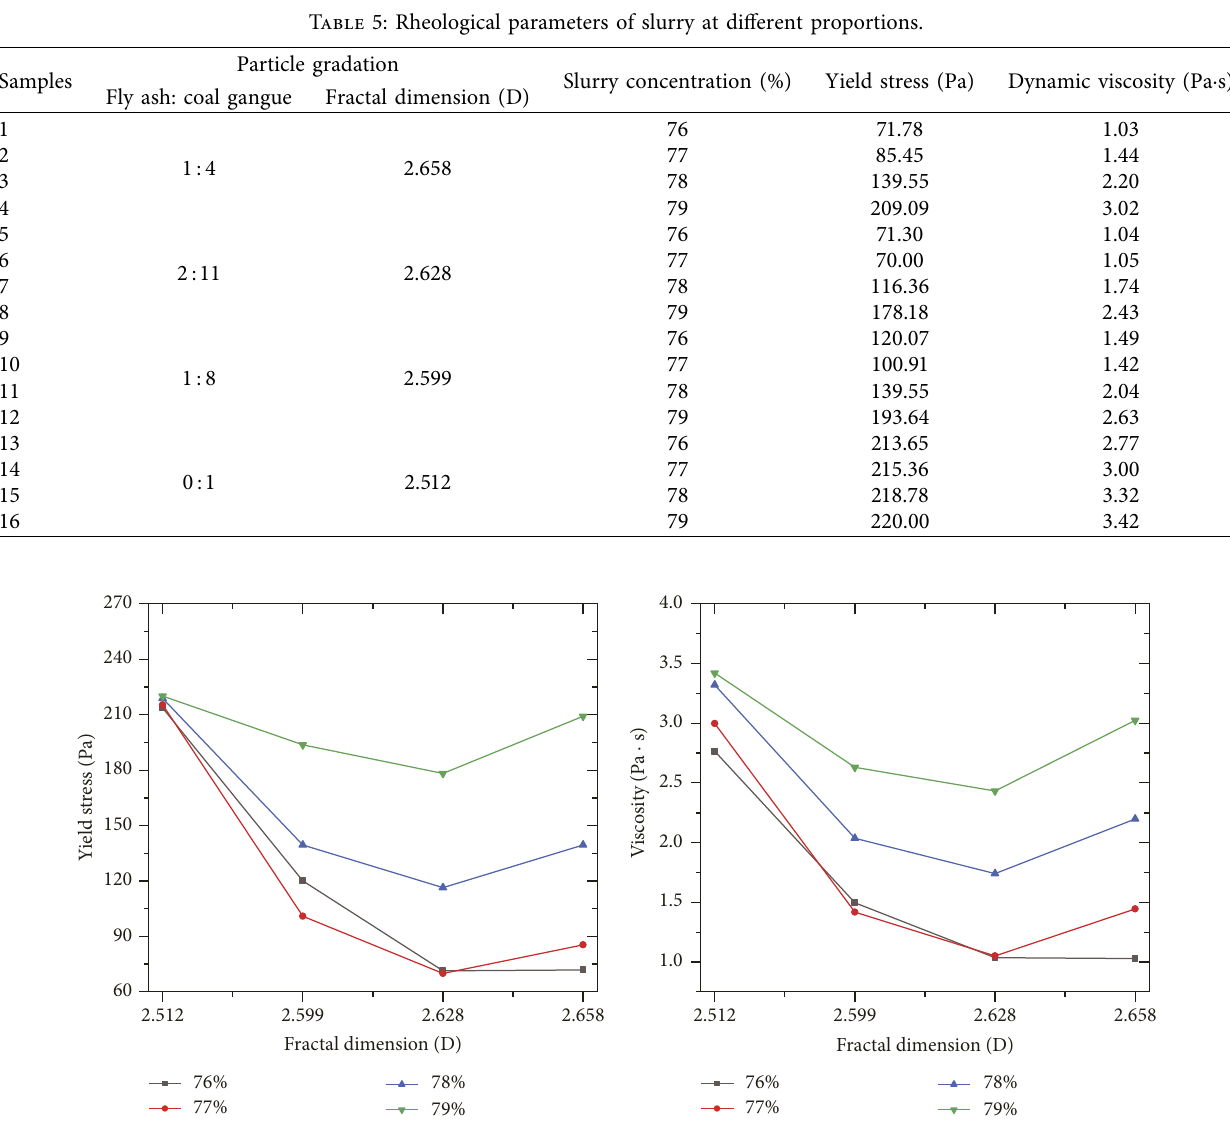
Figure 6: Effect of particle gradation on rheological